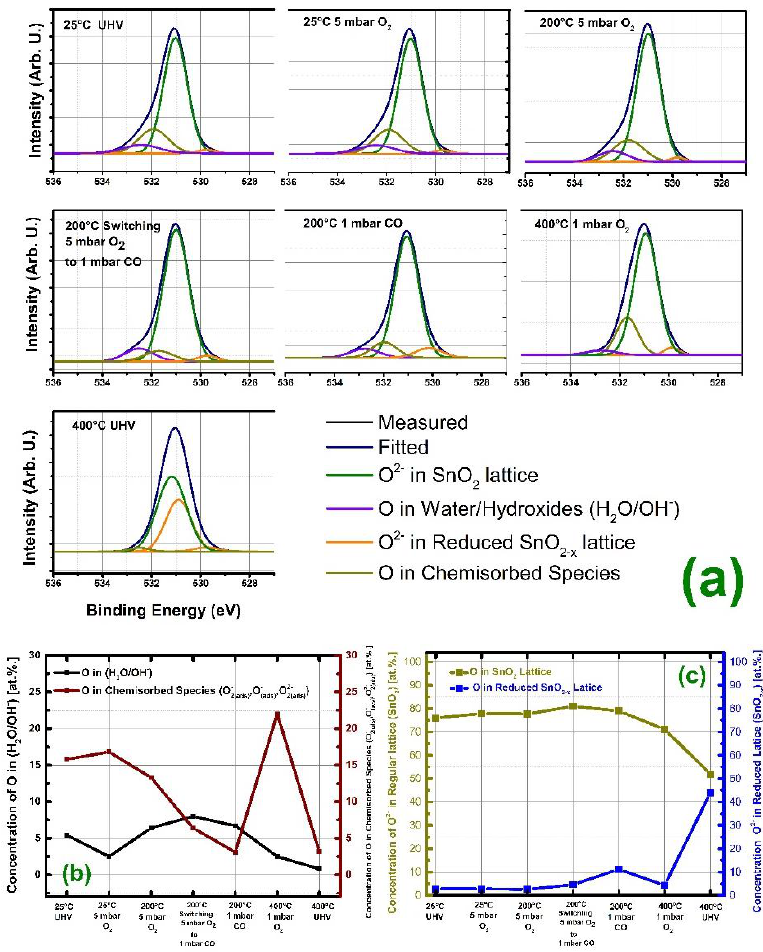
Figure 6. ( a ) Quantification of di ff erent oxygen species upon exposure to various amounts of O 2 and CO gases at di ff erent temperatures completed on deconvolution analysis with precise parameters obtained through Lowdose PM4 measurements in the preceding section. ( b ) shows the concentration of O 2 − ions found in water / hydroxyl groups and chemisorbed species while ( c ) presents the atomic concentration of the O 2 − ions detected in the regular lattice (SnO 2 ) positions and the reduced lattice positions (SnO 2-X ) as a function of temperature, Oxygen and CO gas concentrations. The detailed information regarding the binding energy and concentration can be found in Table